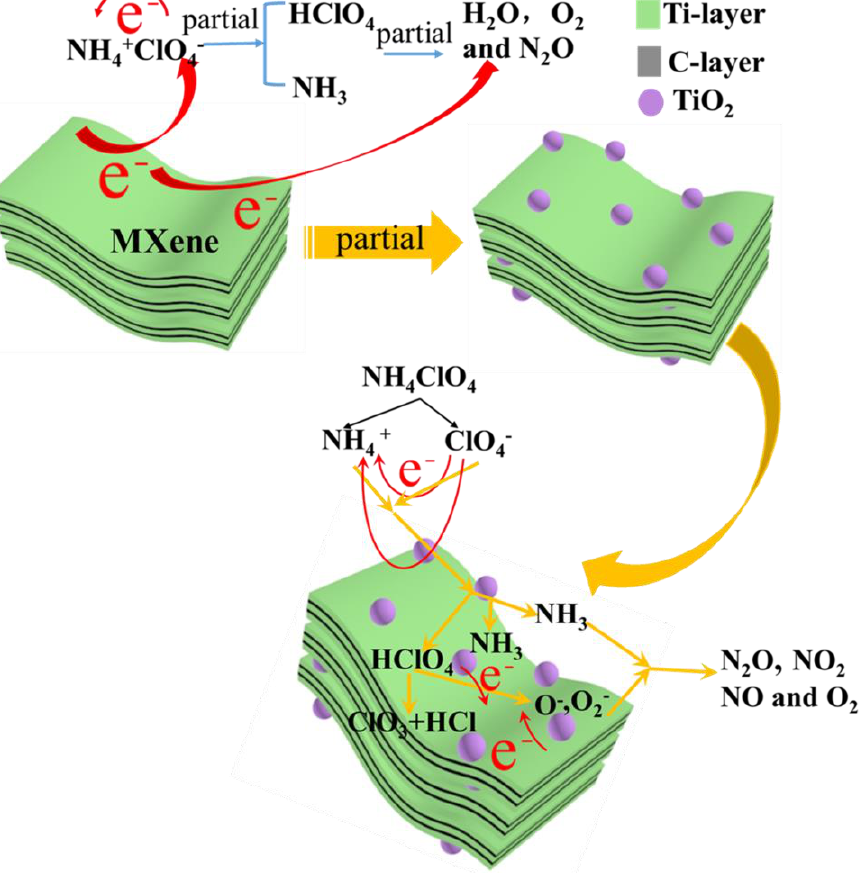
Figure 7. Schematic shows the catalytic mechanism of thermal decomposition of AP by Ti 2 CT x .